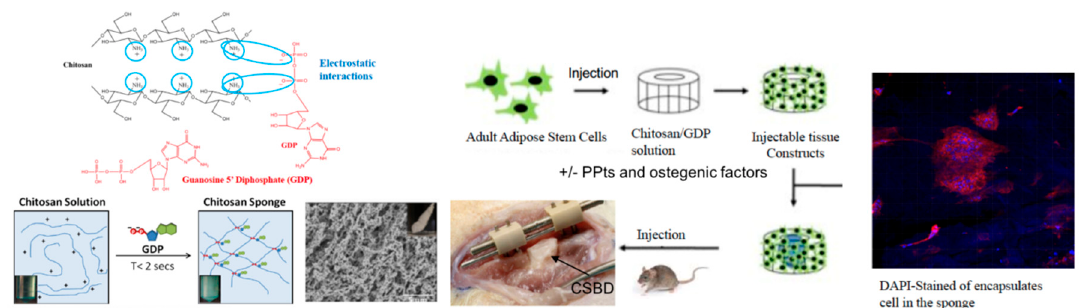
Figure 4. Electrostatic interaction between anionic guanosine 5 ′ -diphosphate (GDP) and cationic chitosan leads to the formation of highly porous scaffold. The encapsulation of adult adipose stem cells (ASCs) and pyrophosphatase (PPtase) can break down GDP and release phosphate ions to promote the biomineralization in a critical size bone defect (CSBD). The image shows the chitosan sponge in CBSD to illustrate the localization of the sponge. There is no need for open surgery in clinical use since the sponge can be directly injected into the CSBD.